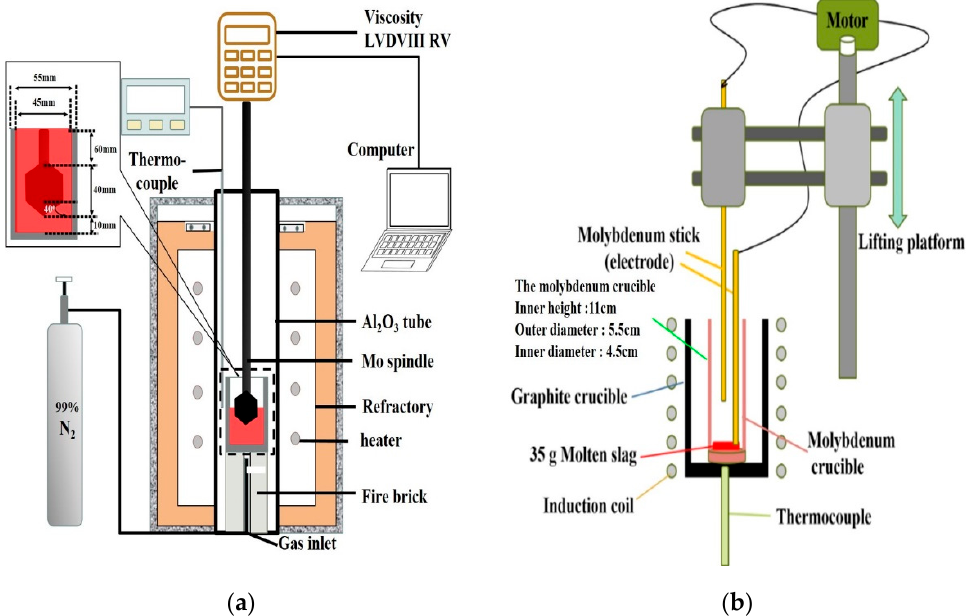
Figure 2. Schematic diagram of ( a ) The Viscosity test ( b ) The foaming life test. The schematic diagram of the foaming life test device (Jia Shing Electricuty Construc-